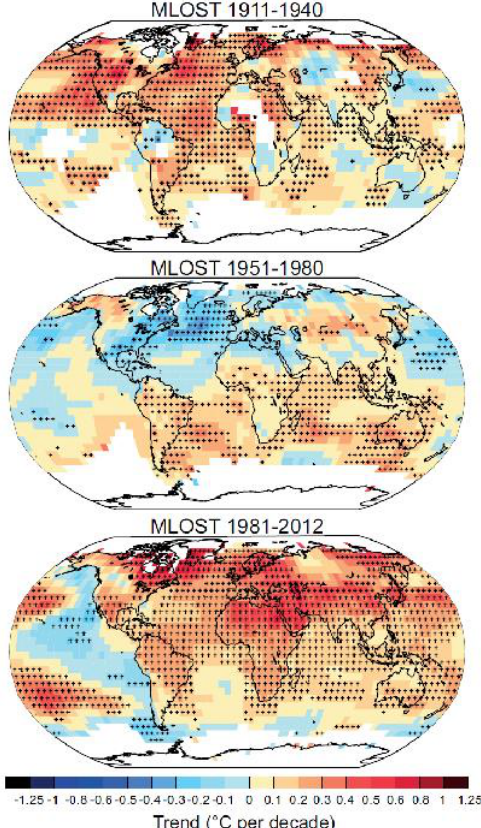
Figure 1. NCDC MLOST GMST trends ( o C/10y) over three separate time periods: 1911-1940, 1951-1980, and 1981-2012 (IPCC 2013) where white signifies incomplete